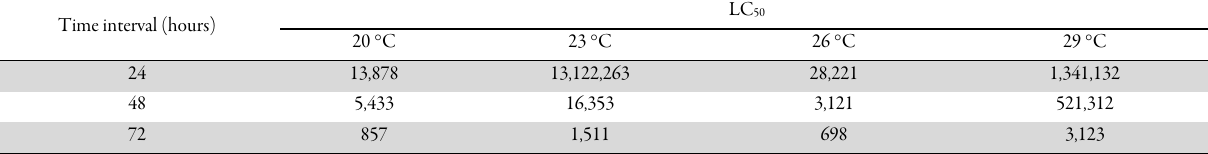
Table 3. Values of LC 50 for S.feltiae on adults of B. lentis at different temperatures and